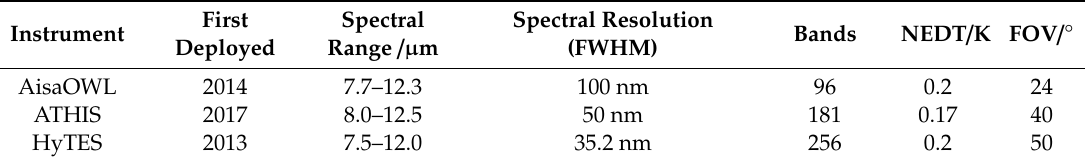
Table 2. Parameters of the considered hyperspectral thermal infrared